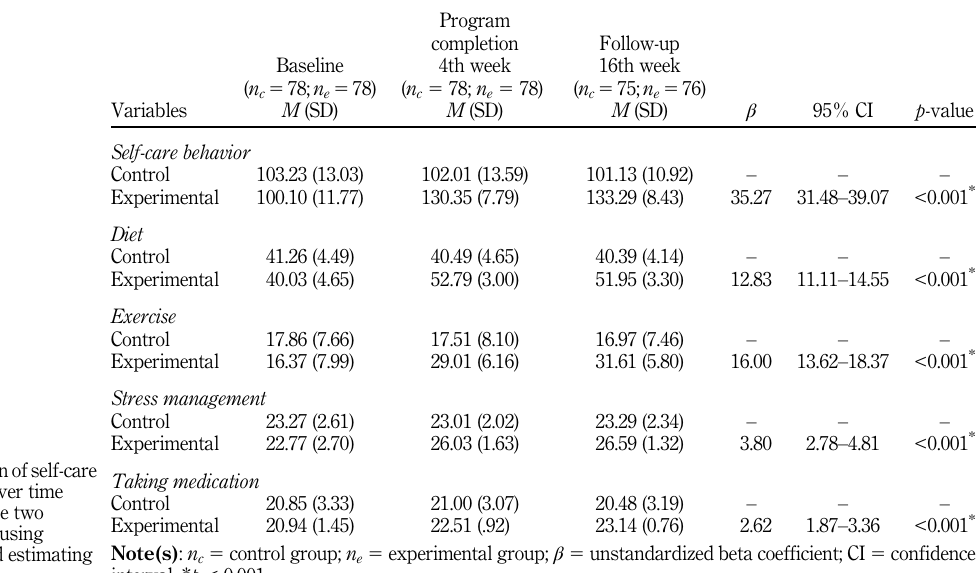
Table 2. Comparisonofself-care behavior over time between the two groups by using generalized estimating